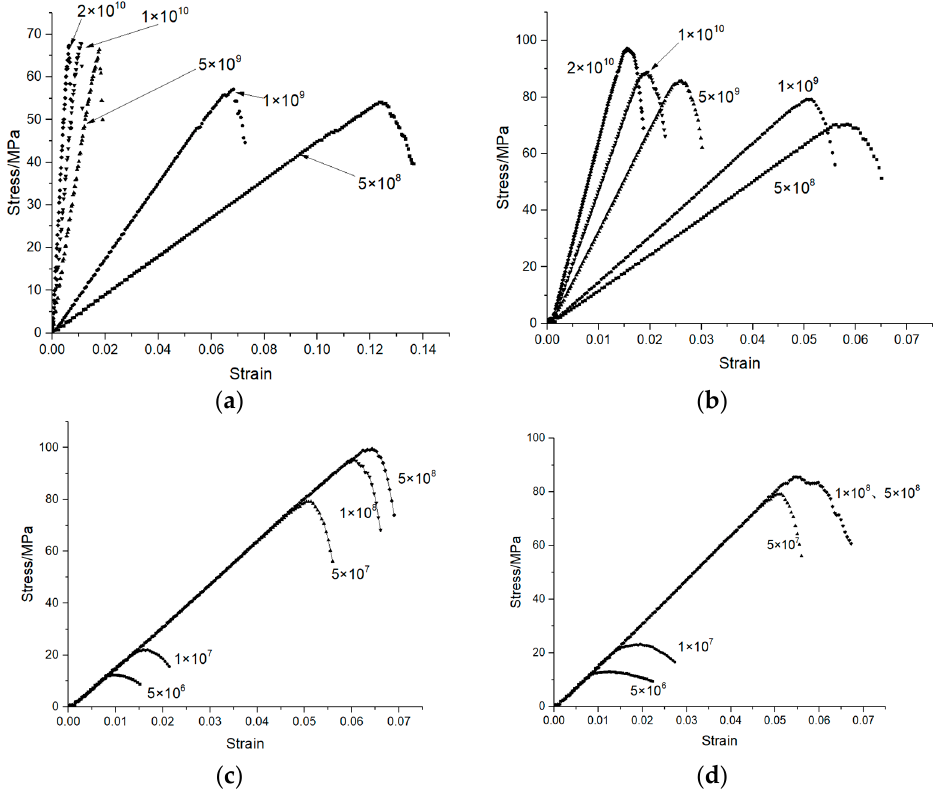
Figure 7. The influence of four main parameters on compressive stress–strain. ( a ) Pb_emod. ( b ) Cb_emod. ( c ) Ten. ( d ) Coh.